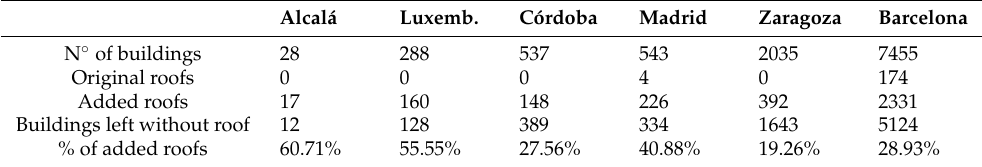
Table 3. Roof results.